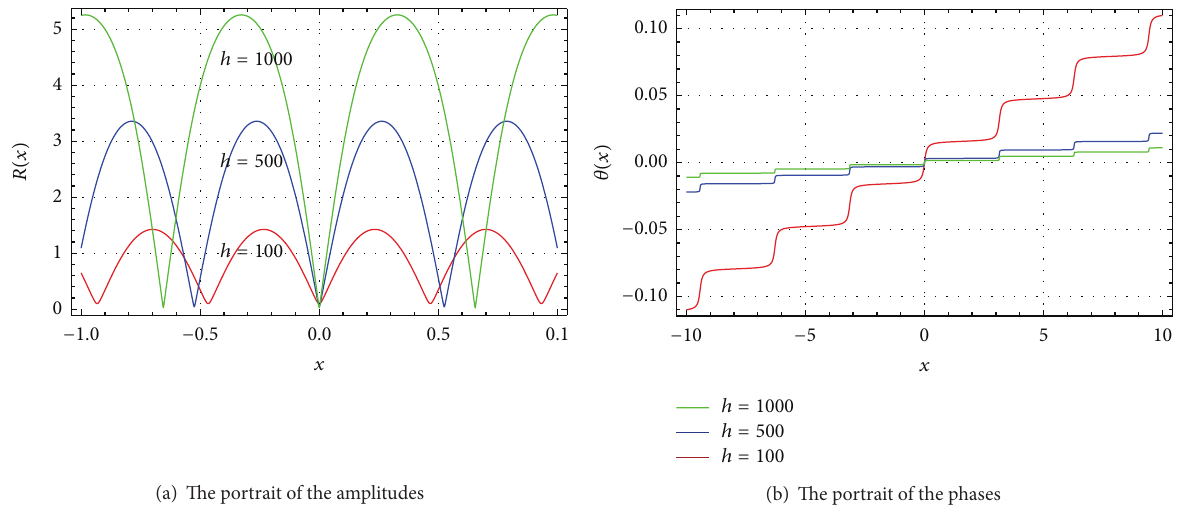
Figure 4: Dynamical evolution of MAWs for an attractive condensate with 𝑔 = −1 , 𝛿 = 50 , 𝑐 = 1 . For each ℎ ∈ (14.1321, 1250.02) , the curve defined by (8) in the phase space is corresponding to a MAW. The period 𝑇(ℎ) of amplitude 𝑅 is increasing with ℎ